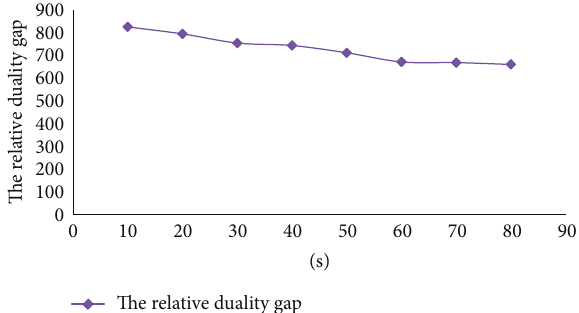
Figure 4: The relative duality gap observed solving the sample problem in dataset 7 in Table 3 (density = 8.5 , 𝑇 = 17 , 𝐾 = 17